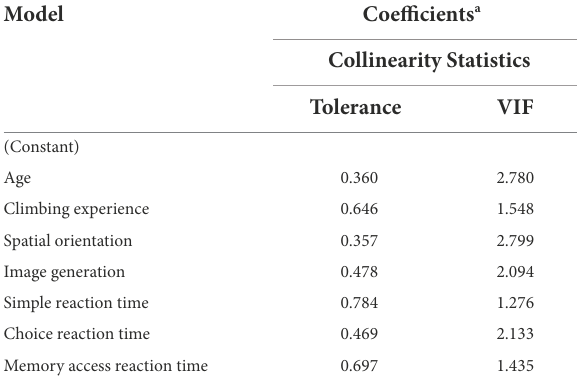
TABLE 7 ANOVA for predicting on-sight